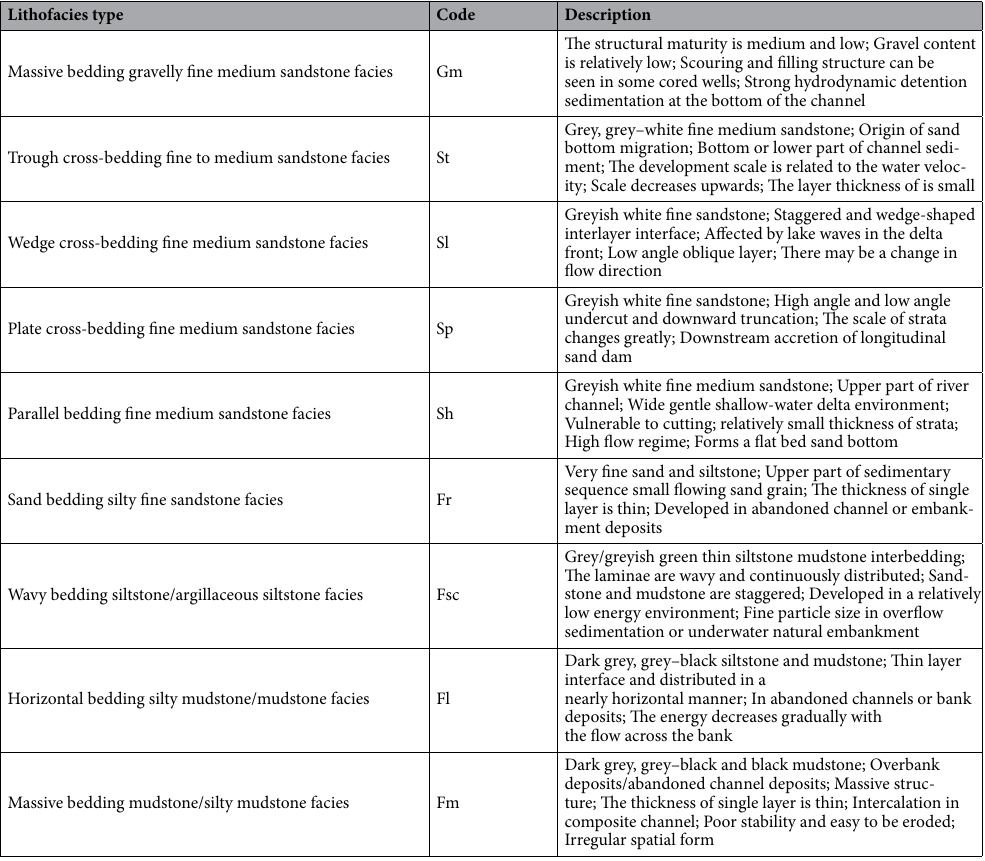
Table 4. Nine lithofacies types based on core observations and petrological characteristics in the study